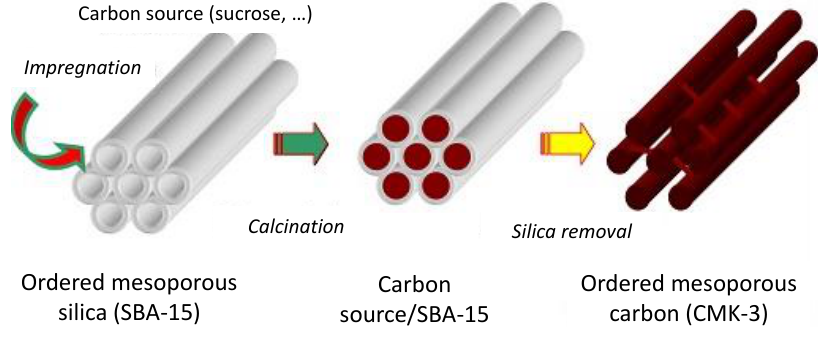
Figure 8. Nanocasting process: Toward the preparation of ordered mesoporous